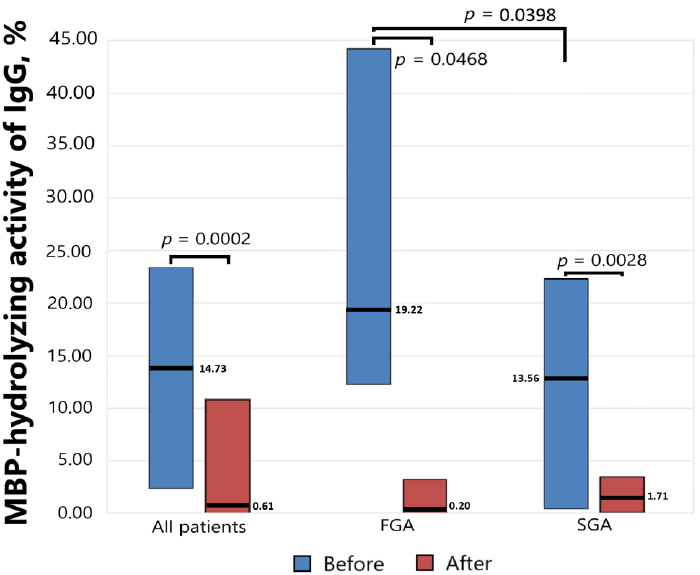
Figure 2. The MBP-hydrolyzing activity of IgGs from the sera of patients with schizophrenia treated with FGAs and SGAs for six